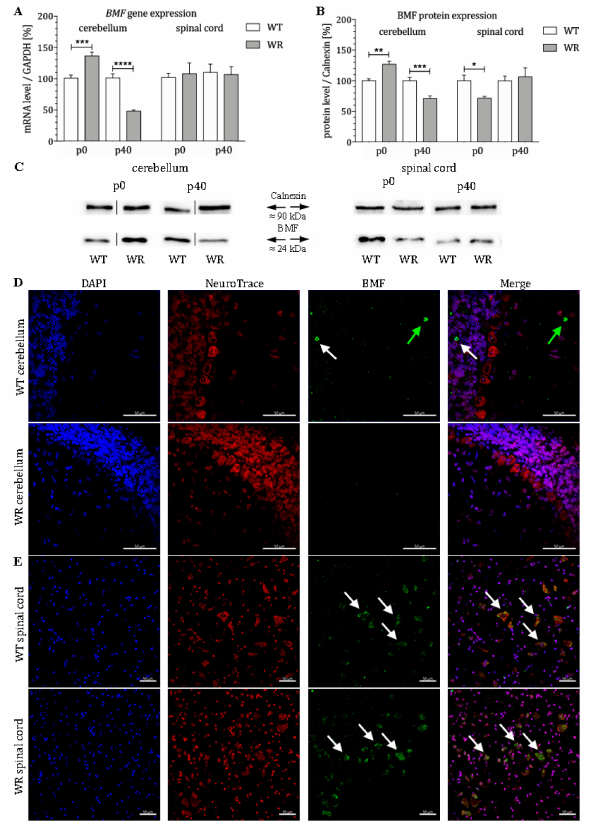
Figure 1. Age-dependent di ff erential expression of BMF in cerebellum and spinal cord of wildtype and wobbler mice. ( A ). BMF mRNA levels at stages p0 and p40 in cerebellum and spinal cord of WT and WR. mRNA expression of BMF from presymptomatic (p0) to stable symptomatic phase (p40) in cerebellum and spinal cord. qPCR was performed using five samples for each genotype and stage. In cerebellum, a significant upregulation of BMF could be detected at stage p0, while a highly significant downregulation could be shown at stage p40. In contrast, no significant regulation could be detected at stages p0 and p40 in spinal cord. For relative quantification of BMF expression, the 2 − ∆∆ Ct method was conducted using the housekeeping gene GAPDH for normalization; data are provided as means ± SEM. Data were tested for significance using Student’s t-test. Significant di ff erences are indicated by * p < 0.05, ** p < 0.01, *** p < 0.001, **** p < 0.0001; n = 5. ( B ). Quantitative analysis of BMF protein expression level in the cerebellum and cervical spinal cord from presymptomatic and stable symptomatic phase of WT and WR mice. At stage p0, a significant upregulation in cerebellar tissue was detected, whereas a highly significant decrease of the BMF protein level appears at stable symptomatic stage p40. In the spinal cord, a significant downregulation at p0 could be observed, while no significantly altered BMF expression could be shown at p40. Data are provided as means ± SEM. Data were tested for significance using Student’s t-test. Significant di ff erences are indicated by * p < 0.05, ** p < 0.01, *** p < 0.001; n = 5. ( C ). Exemplary Western blot of BMF protein expression levels in WT and WR cerebellum and spinal cord at developmental stages p0 and p40. Calnexin was used as control protein. Intensity values of BMF were normalized to calnexin and compared to WT tissue. ( D ). Exemplary immunofluorescence staining of NeuroTrace, as Nissl marker (red), and BMF (green). Scattered staining of BMF could be detected within the granular (white arrow) and molecular (green arrow) layer of the cerebellar slices of WT mice at p40. ( E ). Exemplary immunofluorescence staining of NeuroTrace, as Nissl marker (red), and BMF (green). Specific staining for BMF was found to be located in NeuroTrace positive cells with a large cell body and nucleus, that can be assigned to be motor neuronal cells (white arrows). Nuclei were stained with DAPI (blue). Pictures were taken using a confocal laser scanning microscope (LSM 800, Zeiss, Germany with a 40 × objective (PlanApo 40 × / 1.4 Oil DICII, Nikon instruments). Scale bar = 50 µ